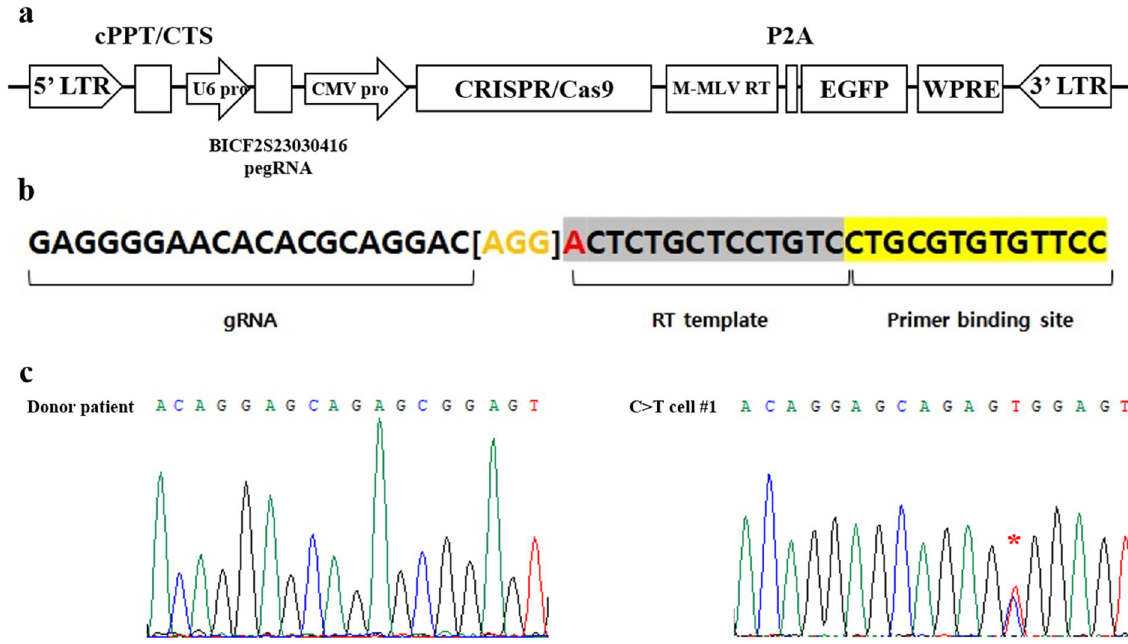
Figure 1. Correction of a point mutation in donor cells using prime editor (PE). ( a ) Schematic of PE vector. It consists of a prime editor that can correct SNP at the BICF2S23030416 locus and EGFP as a reporter. ( b ) Structure and design of PE guide RNA (pegRNA). The bracketed region in orange color indicates the scaffold for pegRNA 17 . The nucleotide (A) in red indicates the SNP mutation site. ( c ) Chromatographic analysis of the donor patient cells and C>T cell #1. The red asterisk indicates the target locus and confirms the C to T sequence correction mediated by